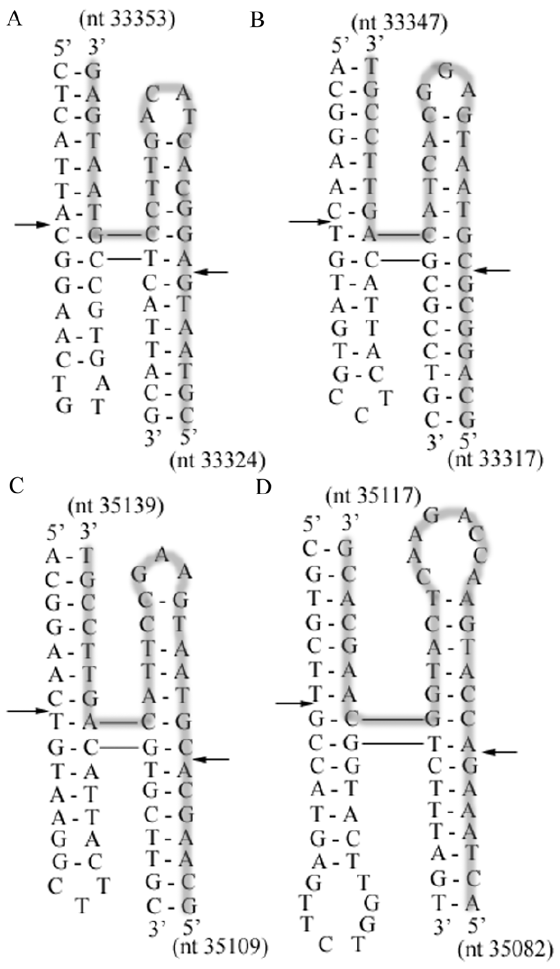
Figure 3. Structures of four-way junctions in gene 17 of T3 and T7. (A) T3 nt 33324–33353 (B) T3 nt 33317–33347 (C) T7 nt 35109– 35139 (D) T7 nt 35082–35117. One strand is highlighted in grey; the other is not. Arrows indicate Endo I cutting sites.